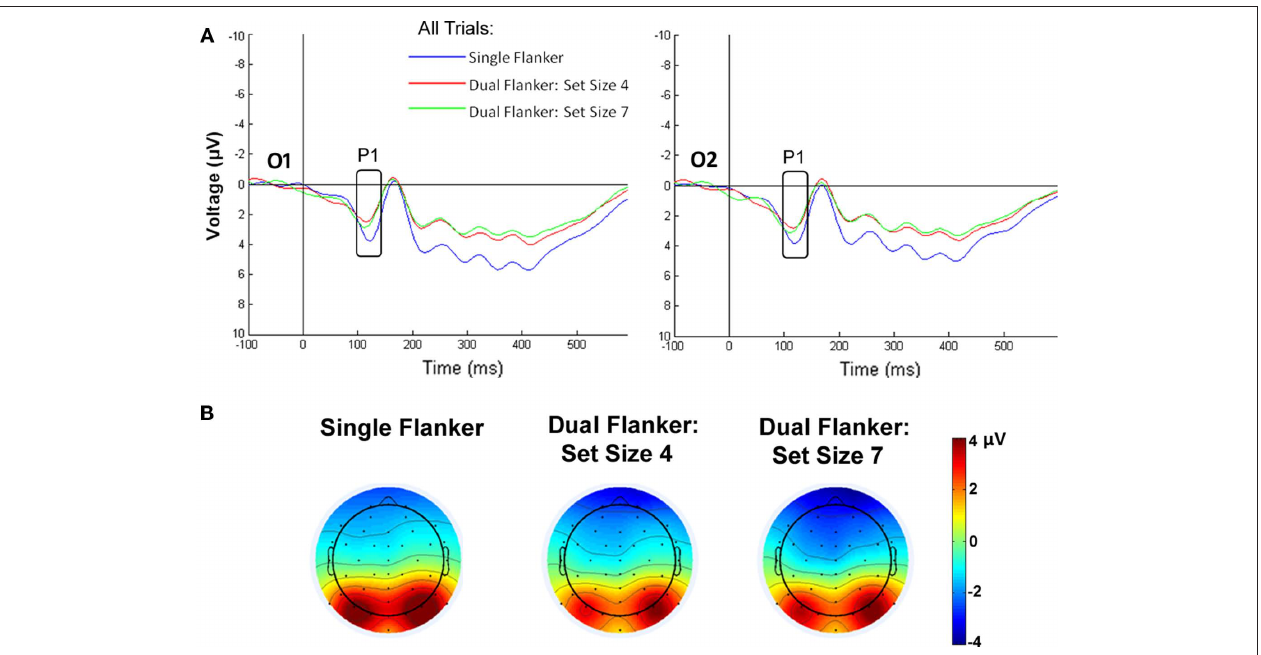
FiguRE 4 | P1 in response to load. (A) The dual task conditions significantly diminished P1 amplitude at electrode O1 and O2, compared to the P1 amplitude for the single task. (B) Topographic maps display the scalp voltage distribution at 120 ms, indicating that the P1 is located over both O1 and O2 electrodes for each task